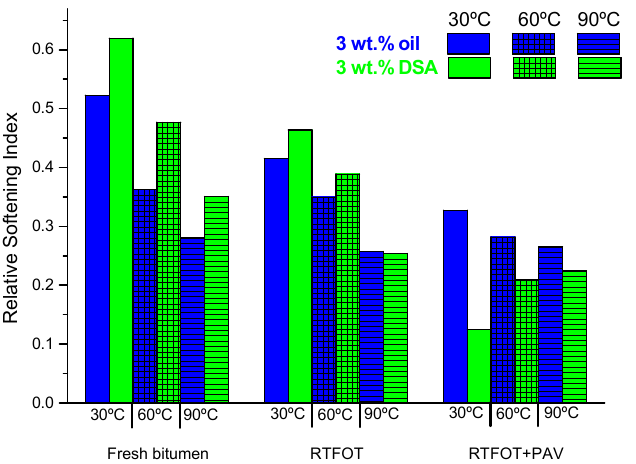
Figure 8. Relative Softening Index values for neat and modified bitumen after ageing by RTFOT + PAV at different testing temperatures.